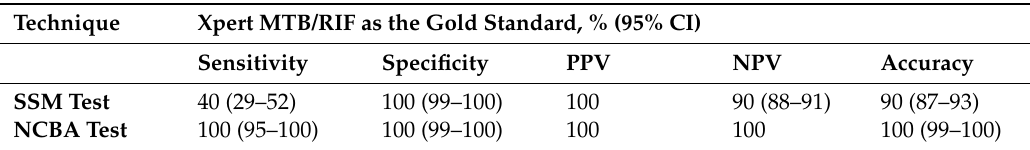
Table 2. Comparison of diagnostic performance.